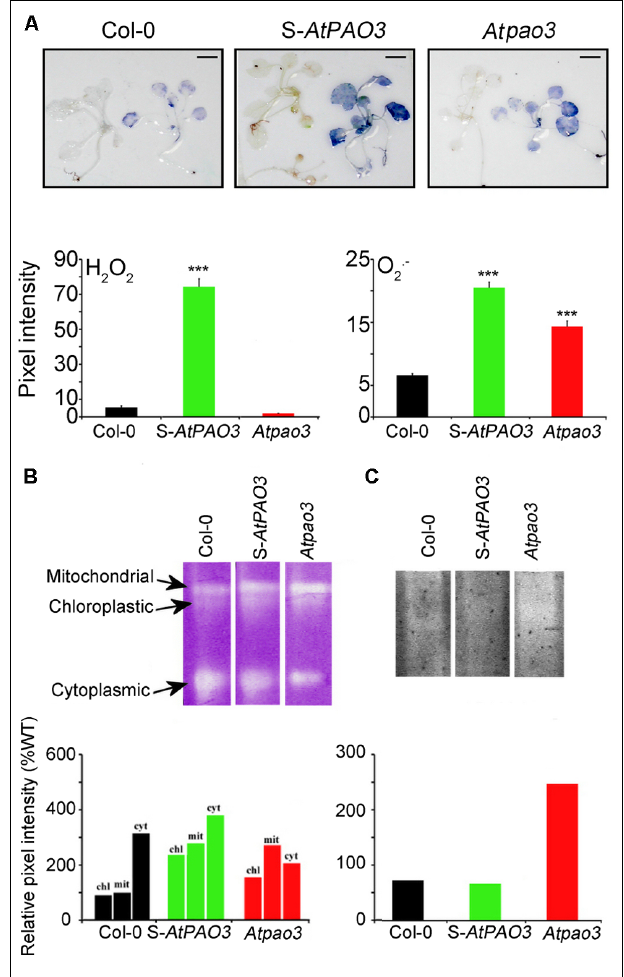
FIGURE 4 | In situ ROS inWT, S- AtPAO3, and Atpao3 Arabidopsis plants. (A) In situ ROS detection inWT, S- AtPAO3 and Atpao3 plants. Data are from a single representative experiment, repeated three times, and densitometric analysis. Data are the means of three different positions on a leave. Asterisks indicate statistical significant differences from the Col-0 (*** P < 0.001). Scale bars, 2.8 cm. (B) Native electrophoresis and activity staining of SOD and densitometric analysis of isoenzymes. (C) Native electrophoresis and activity staining of APX and densitometric